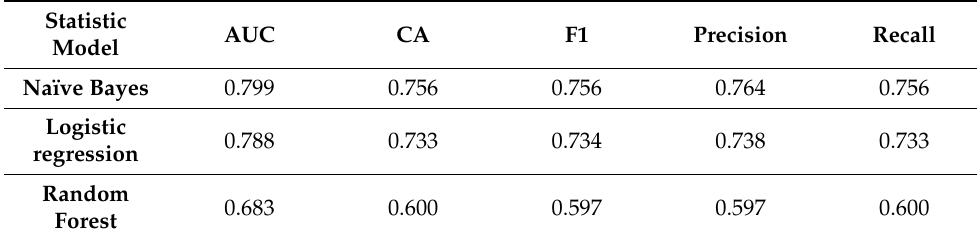
Table 5. Head-to-head comparison of the area under the curve results for the classification accuracy yielded by magnesium, uric acid, and the five metabolites using three supervised classification algorithms.